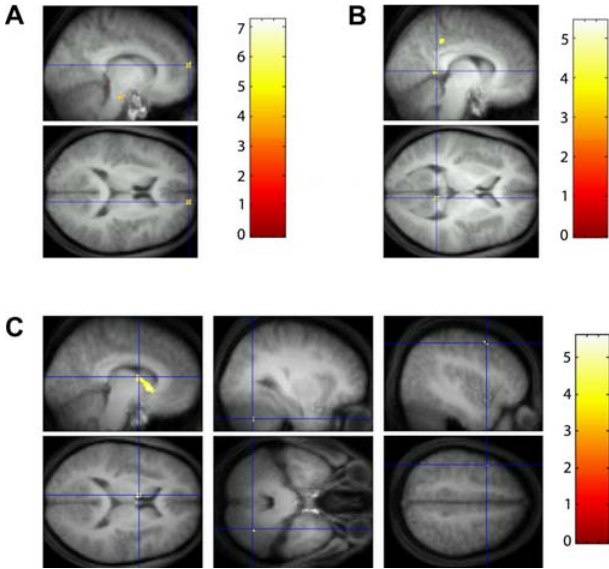
Figure 4. Offline Modulation of Cerebral Connectivity during Post- Training Wakefulness Offline spatial learning-related connectivity: (A) Tighter coupling during Session II than during Session I between hippocampus (at coordinate 26 (cid:1) 24 (cid:1) 8 mm) and superior frontal gyrus activity (cross hair at [12 66 16 mm] Z ¼ 3.87; p svc(10mm) , 0.05), superimposed on participants’ average anatomical T1-weighted MRI image. Color bars indicate magnitude of effect size. (B) Delayed tighter coupling during Session III than during Session I between hippocampus (26 (cid:1) 24 (cid:1) 8 mm) and retrosplenial cortex (cross hair at [8 (cid:1) 48 8 mm]), Z ¼ 3.42, p svc(10mm) , 0.05). (C) Offline procedural learning-related connectivity: Delayed enhancement in coupling during Session III as compared to Session I, between cerebellum activity (at coordinate 2 (cid:1) 60 28 mm) and activity in the caudate nucleus (left panel: [ (cid:1) 8 2 14 mm] [cross hair], and [ (cid:1) 18 (cid:1) 14 24 mm], Z ¼ 3.99 and 3.71, p svc(10mm) , 0.05), the putamen ([20 2 (cid:1) 4 mm], data not shown, Z ¼ 3.56, p svc(10mm) , 0.05), the lateral cerebellum (middle panel: cross hair at [32 (cid:1) 66 (cid:1) 36 mm], Z ¼ 3.33, p svc(10mm) , 0.05), and the dorsal premotor cortex (right panel: cross hair at [ (cid:1) 44 10 54 mm], Z ¼ 3.16, trend p svc(10mm) ¼ 0.07). DOI: